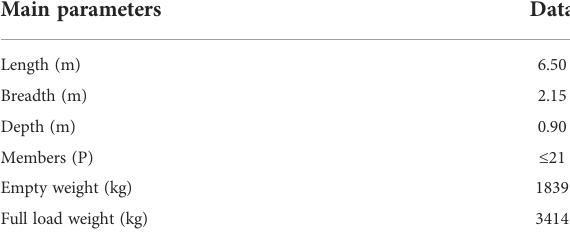
TABLE 1 Performance parameters of the open lifeboats.